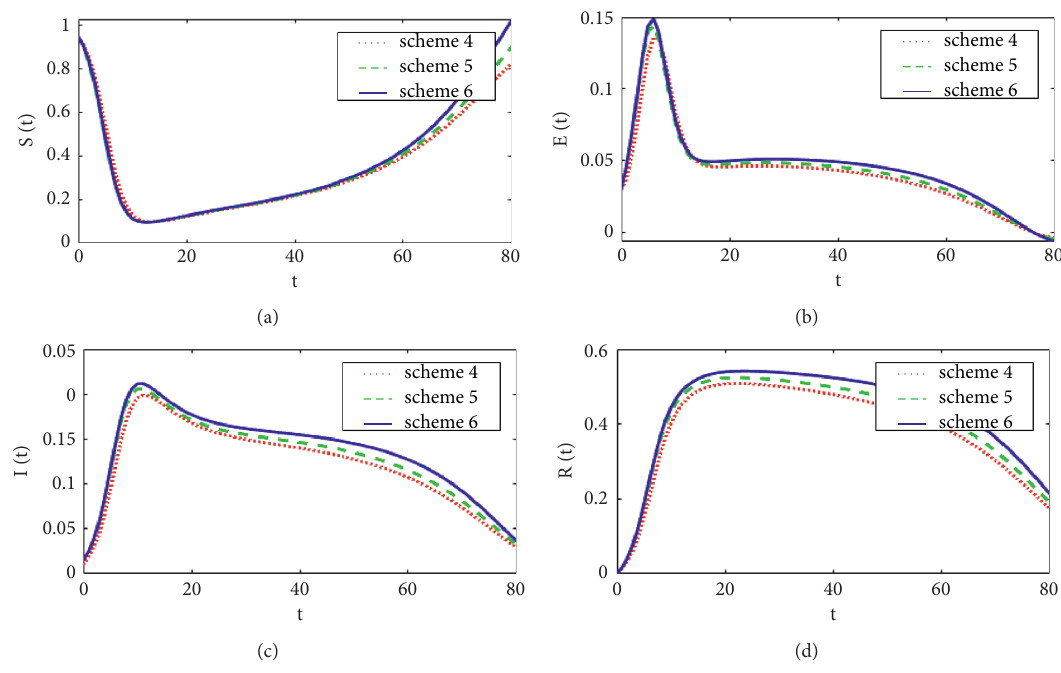
Figure 3: Curves of changes in the population density of netizens in the four categories at different values of k .